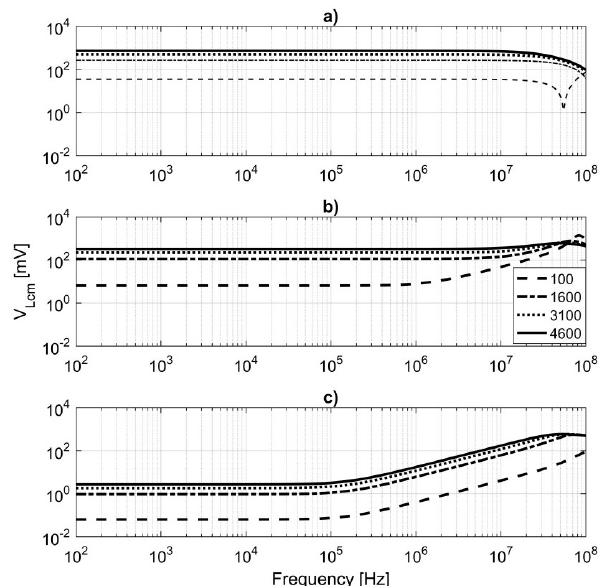
Fig.16: Simulated common mode load voltage ( V Lcm ) of the non- differential EHCS for four different loads. The values shown in the legend are the value of the loads in Ω. a) EHCS-DIF b) BRIDGE-1 c) BRIDGE-2.